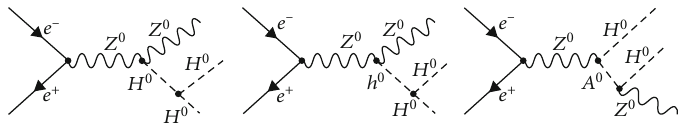
Figure 12: Feynman diagrams contributing to the scattering process e − e + ⟶ ZHH at ILC.